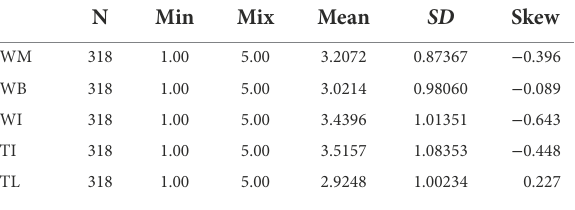
TABLE 2 Descriptive statistics.